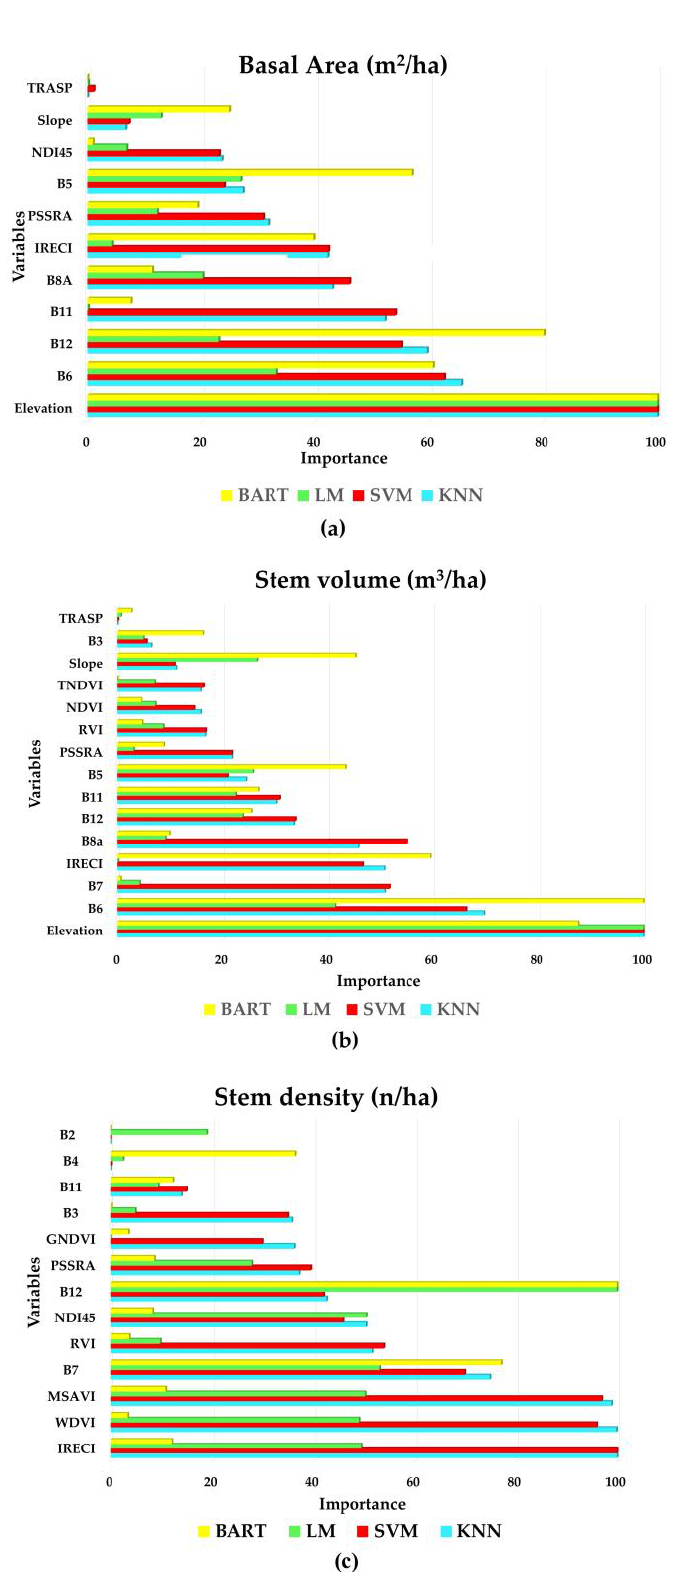
Figure 4. Significance of variables for each ML model for predicting: ( a ) basal area, ( b ) stem volume, and ( c ) stem density.